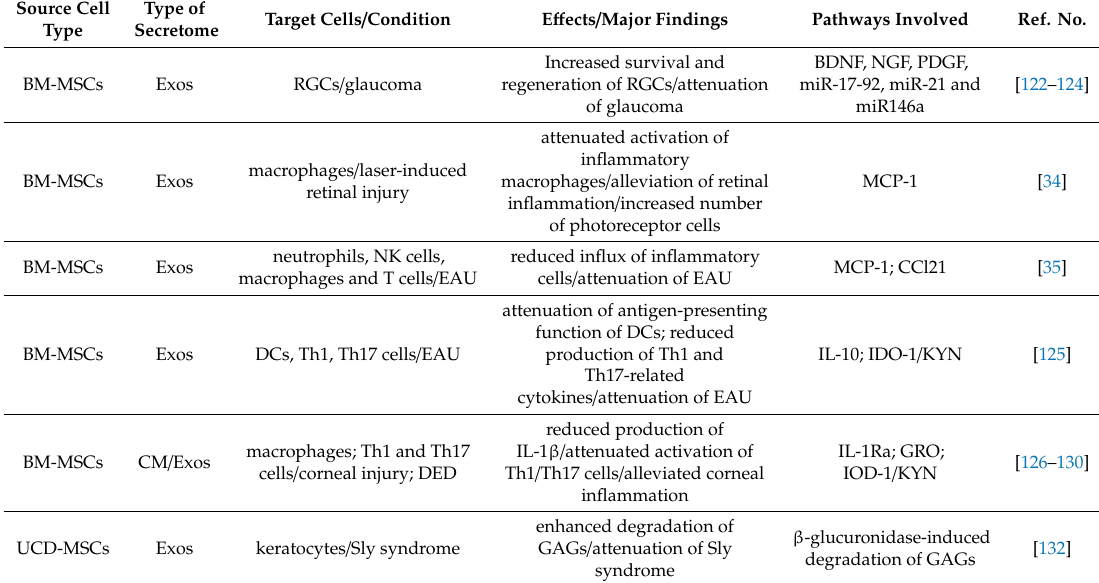
Table 6. Therapeutic potential of MSC-derived secretome in the therapy of eye